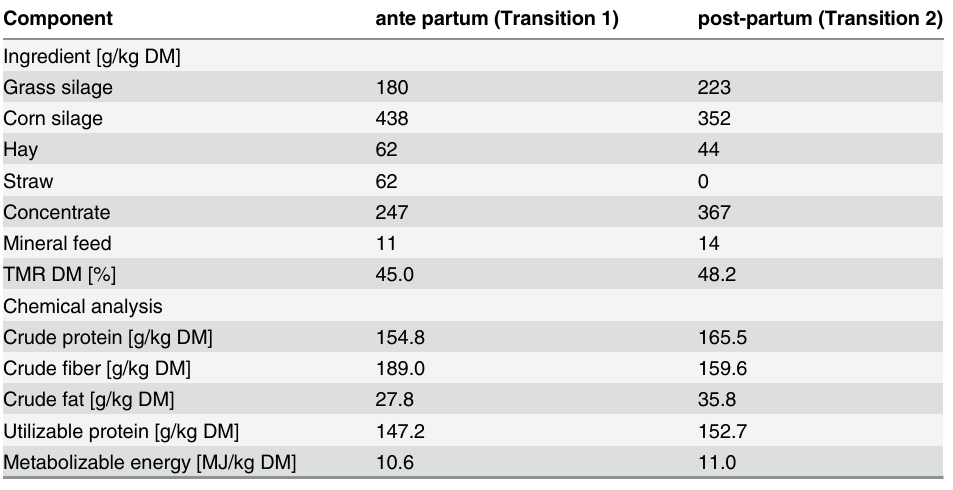
Table 2. Components and chemical analysis of TMR diets ante and